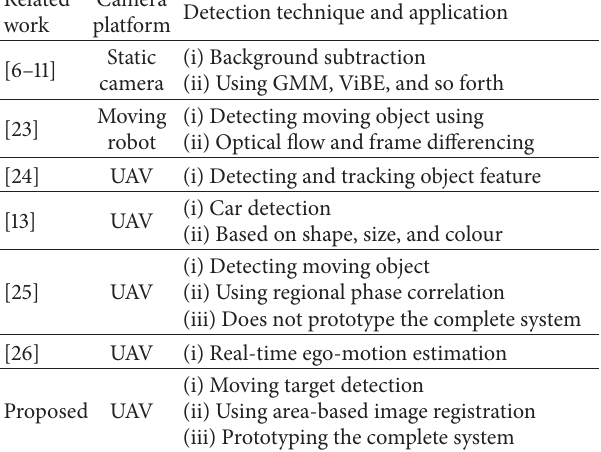
Table 1: Comparison between related works on FPGA-based object detection system for different applications with proposed